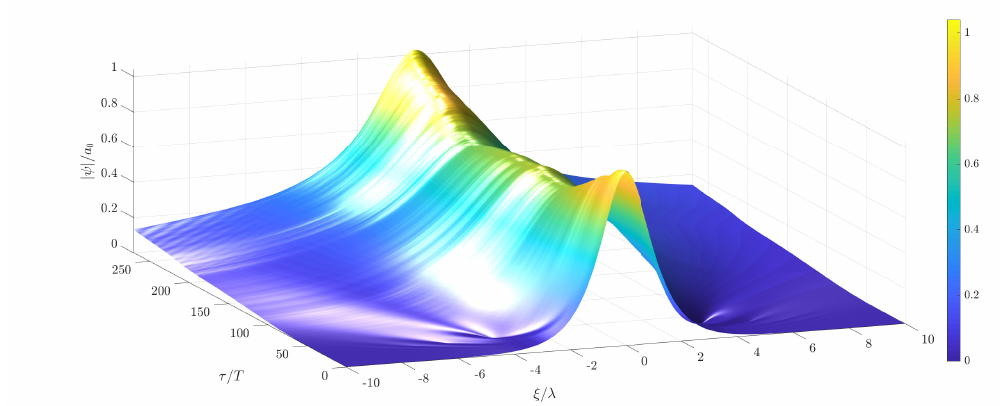
Figure 19. Temporal evolution of a soliton solution of the stochastic MNLS with non-white noise excitation in time using laboratory scale parameters a 0 = 0.75 cm, ω = 10.68 rad/s, k = 11.64 1/m, mean wind velocity V m = 4 m/s and σ v = 2